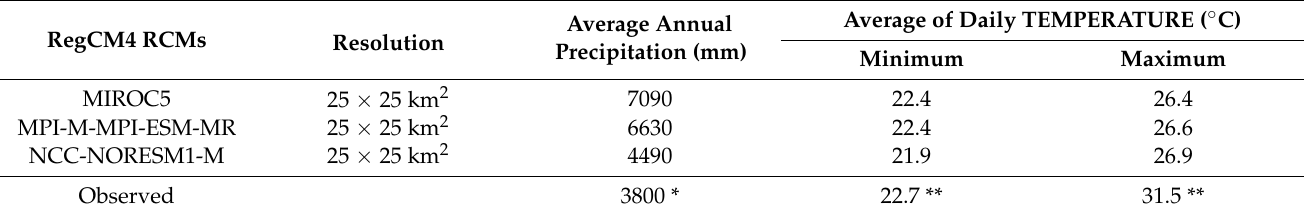
Table 1. Regional climate model (RCM) predictions and observations over the basin for the 1991–2005 period. * based on 24 stations and ** based on 3